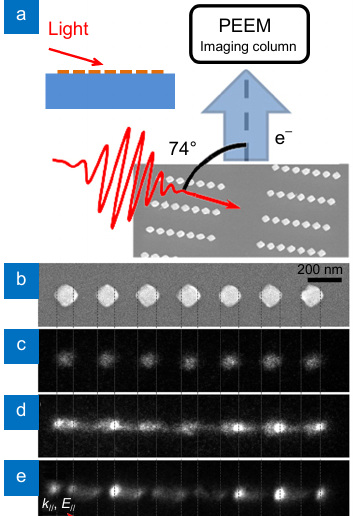
Fig. 2 | ( a ) Sketch map of the light illumination for the PEEM meas- urements. ( b ) SEM image of an Au nanochain with the designed gap size of 100 nm; PEEM images of the Au nanochain under different irradiation conditions: ( c ) mercury lamp, ( d ) mercury lamp and femtosecond laser pulses, and ( e ) femtosecond laser pulses. The dashed lines indicate the positions of the hot spots. The in-plane wave vector k // and polarization E // for the incident laser pulses are indicated in